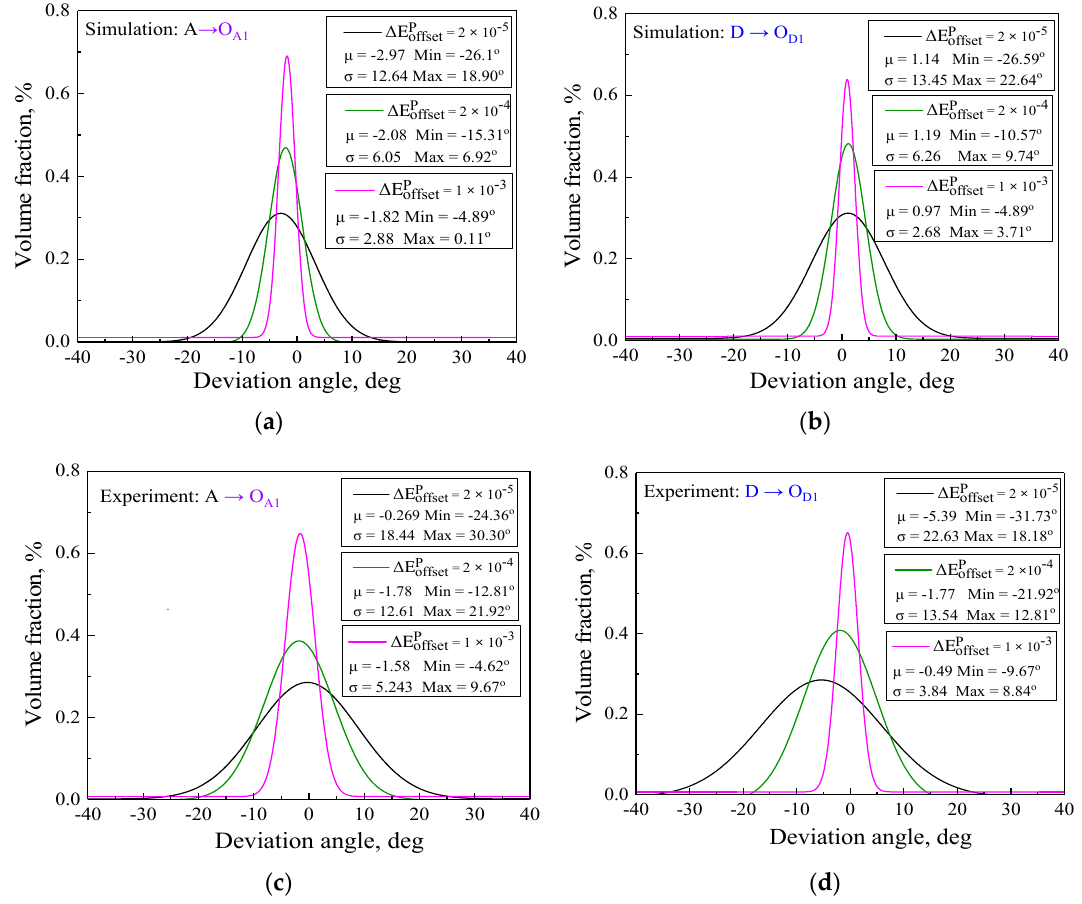
Figure 13. The statistical distribution of the deviation angles between the plastic flow direction and the normal direction of the yield surface: ( a ) simulated statistical distribution at unloading points O A1 ; ( b ) simulated statistical distribution at unloading points O D1 ; ( c ) experimental statistical distribution at unloading points O A1 ; ( d ) experimental statistical distribution at unloading points O D1 .